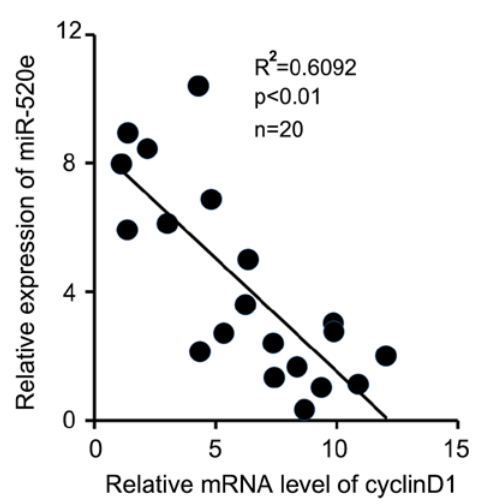
Figure 4: In human clinical breast cancer tissues, miR-520e is positively correlated with cyclinD1. The correlation of miR-520e and cyclinD1 was analyzed in clinical breast cancer tissues (Pearson′s correlation coefficient,